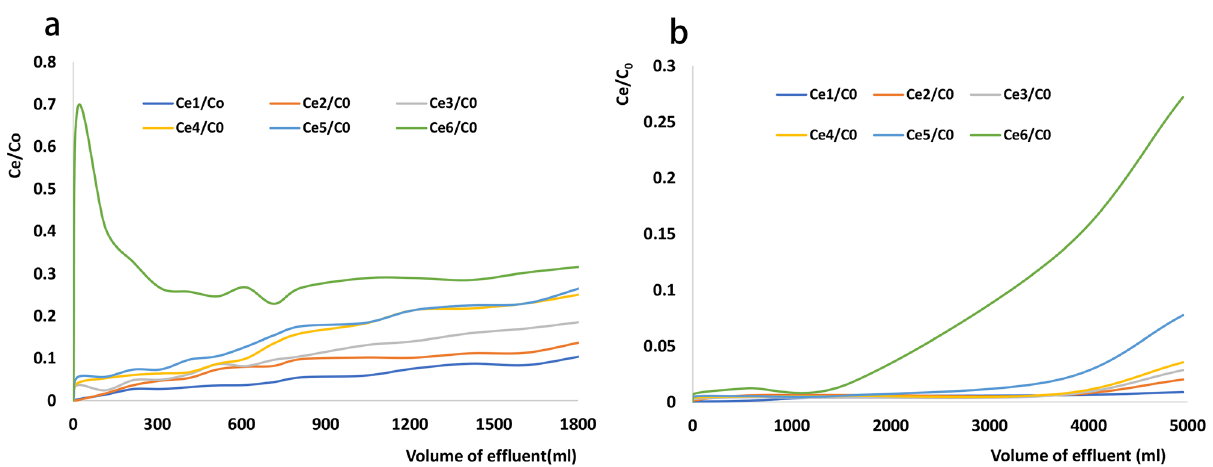
Figure 4. Results of regenerability testing obtained for columns with ( a ) 0.3 g of rGO/NZV-FeZn at an initial Sb concentration of 0.9324 mg L −1 and ( b ) 3.5 g of rGO/NZV-FeZn at an initial Sb concentration of 0.8111 mg L −1 . Run